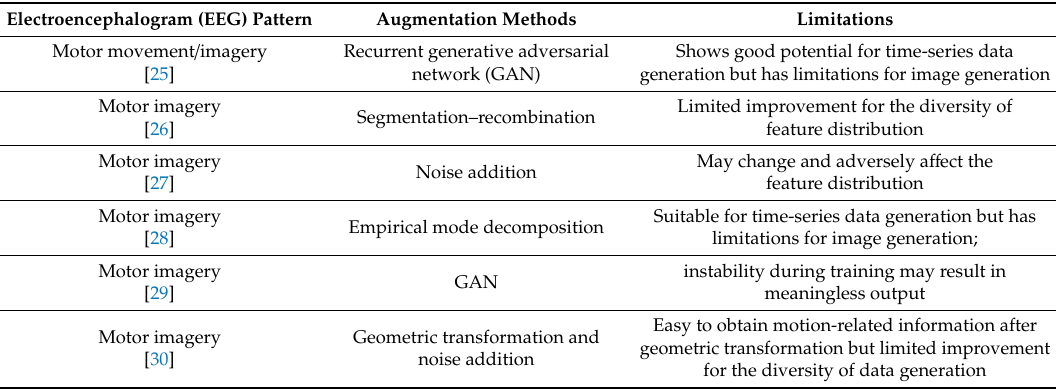
Table 1. Data augmentation for motor imagery